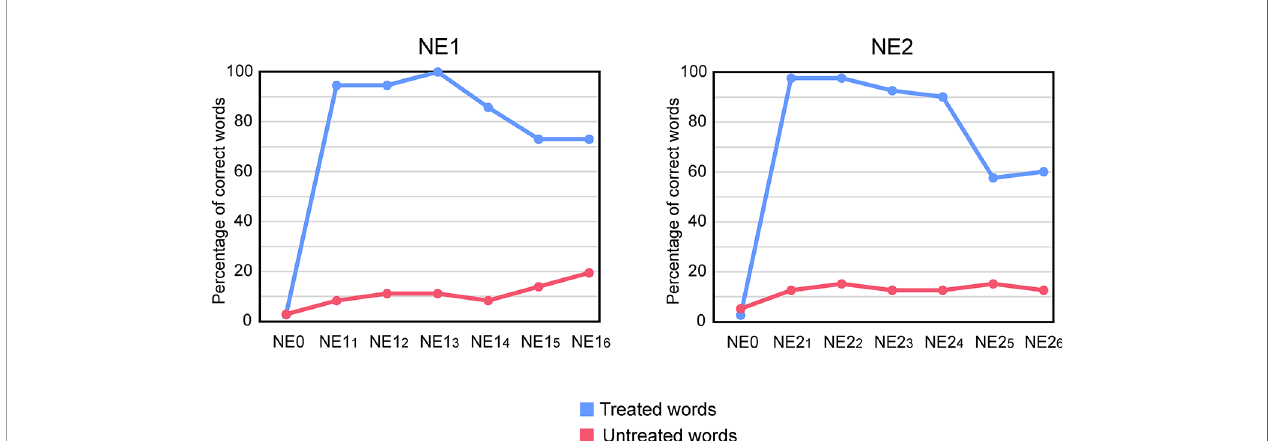
FIGURE 3 | Performance of subject P in the multiple naming evaluations (NE). Percentage of correct words in each evaluation is shown. NE0 indicates the performance in the baseline NE performed before INT1. NE0 at the left of NE1 1-6 indicates pre-treatment performance for the treated and untreated words used in INT1 and NE1 1-6. NE0 at the left of NE2 1-6 indicates pre-treatment performance for the treated and untreated words used in INT2 and NE2 1-6. Six NEs were performed after INT1 (NE1 1-6 ) and after INT2 (NE2 1-6 ). NE1 1-6 and NE2 1-6 were performed: 20 min after the end of each INT (NE1 1 and NE2 1 ), and at days 2 (NE1 2 and NE2 2 ), 7 (NE1 3 and NE2 3 ), 21 (NE1 4 and NE2 4 ), 49 (NE1 5 and NE2 5 ), and 84 (NE1 6 and NE2 6 ) after the end of each